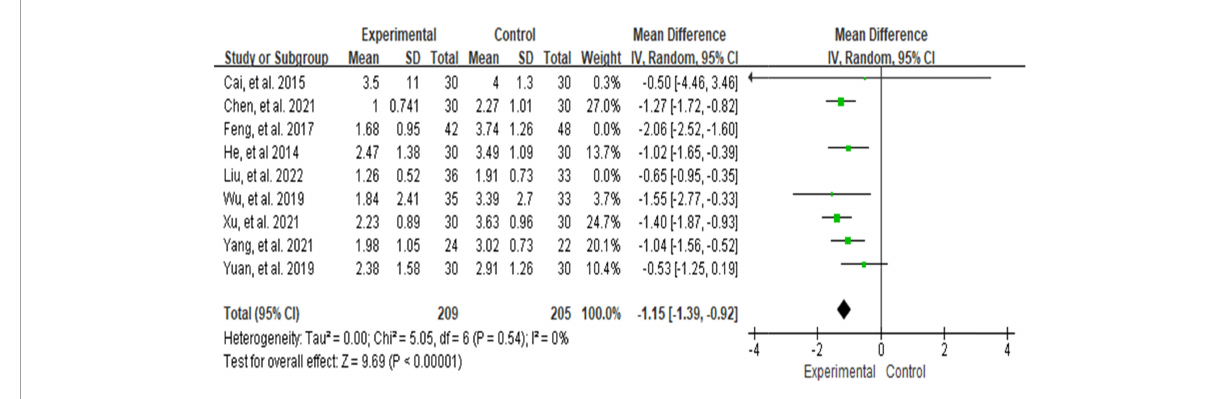
FIGURE7 Forest plot of the effect of Baduanjin on reducing VAS after sensitivity analysis.